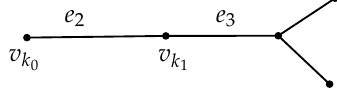
Figure 6. For Step 5: a subtree of Ω 2